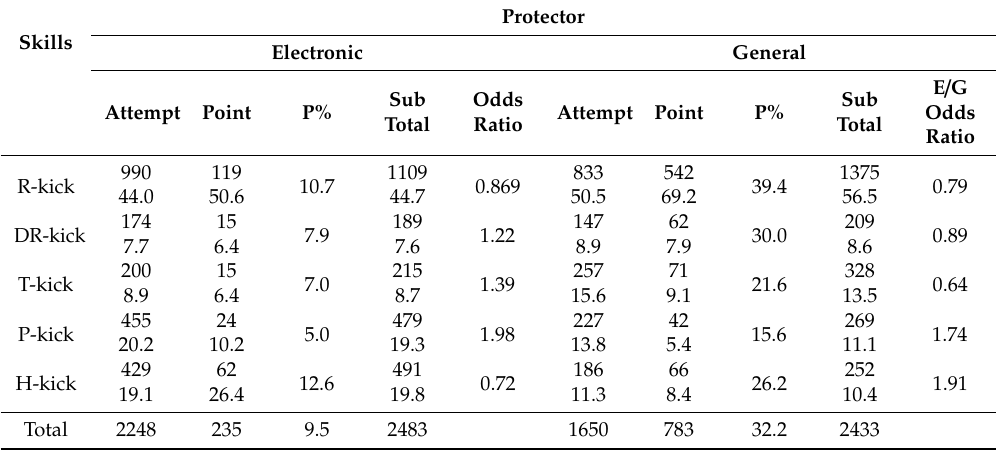
Table 5. Observed frequencies for attempt and point (%) and odd ratios for protector by skill contingency